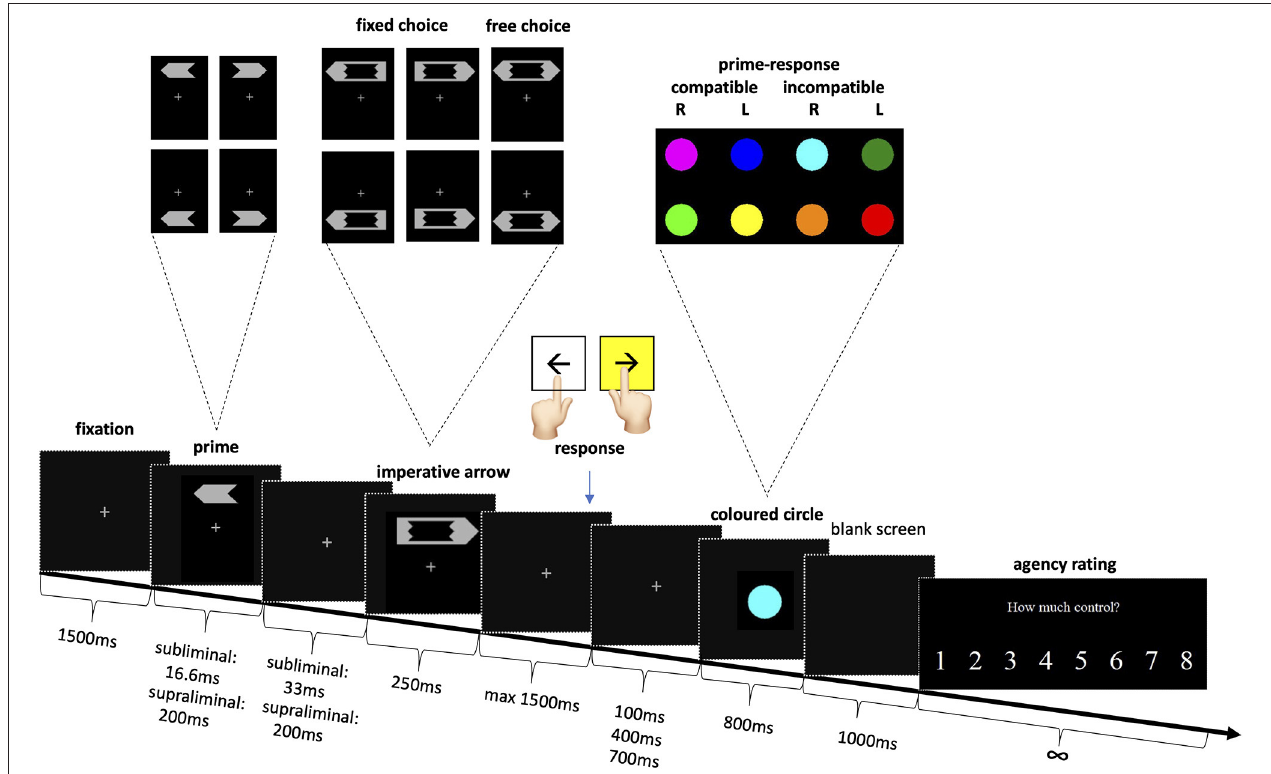
FIGURE 1 | Experimental setup for subliminal and supraliminal priming with agency rating. Stimuli sizes in visual angle: prime height 0.8 ◦ , length 1.86 ◦ , mask height 1.09 ◦ , length 3.26 ◦ , circle diameter 1.86 ◦ .